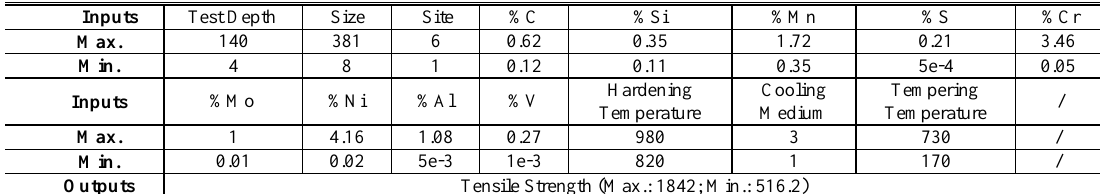
Table 3. The inputs and output of UTS data